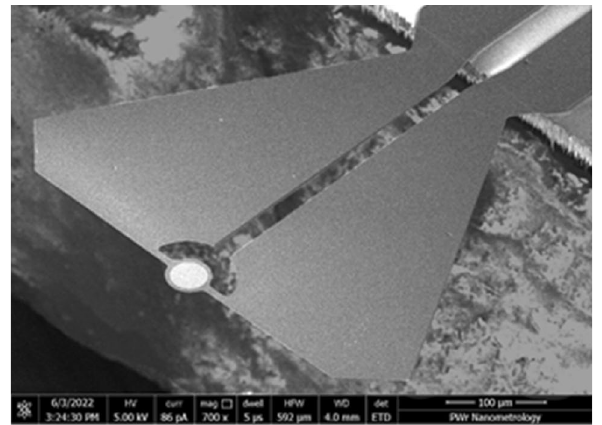
Figure 7. Scanning electron microscope images of a thermally enhanced pfMEMS microcantilever for PF